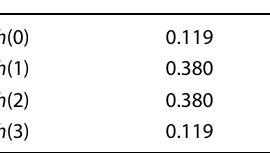
Table 3 Kaiser window transfer function coefficient